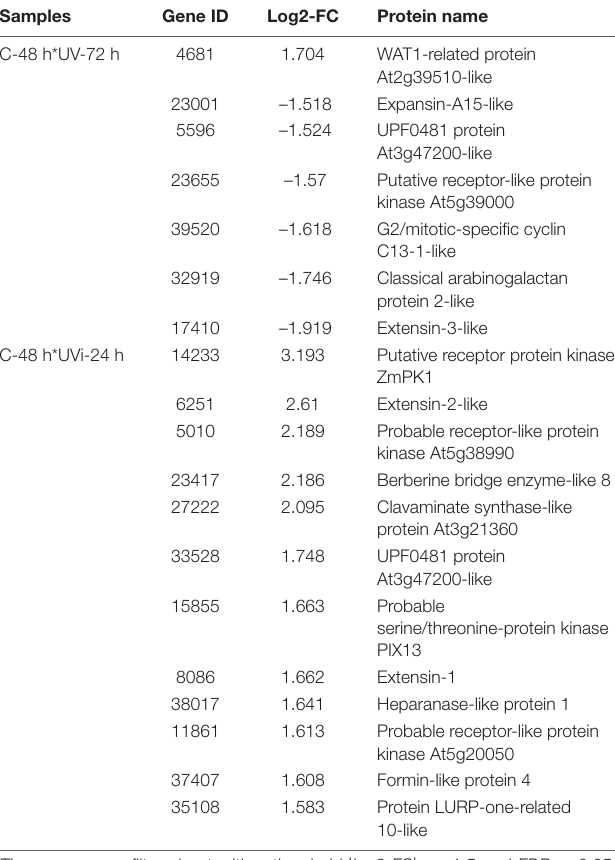
TABLE 5 | Relative expression of cell wall